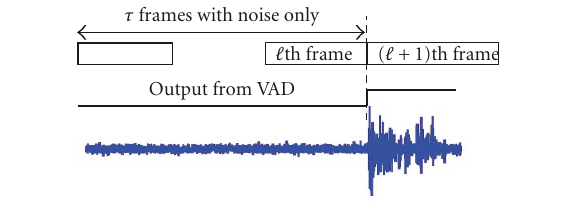
Figure 1: Setup for performance analysis of power subtraction. Each data frame is of length N , where N is assumed to (roughly) coincide with the short-time stationarity of the speech. The back- ground noise is assumed long-time stationary over τ + 1 frames. A perfect voice activity detector (VAD) is assumed, where its output speech presence probability (0% or 100%, resp.) is indicated in the